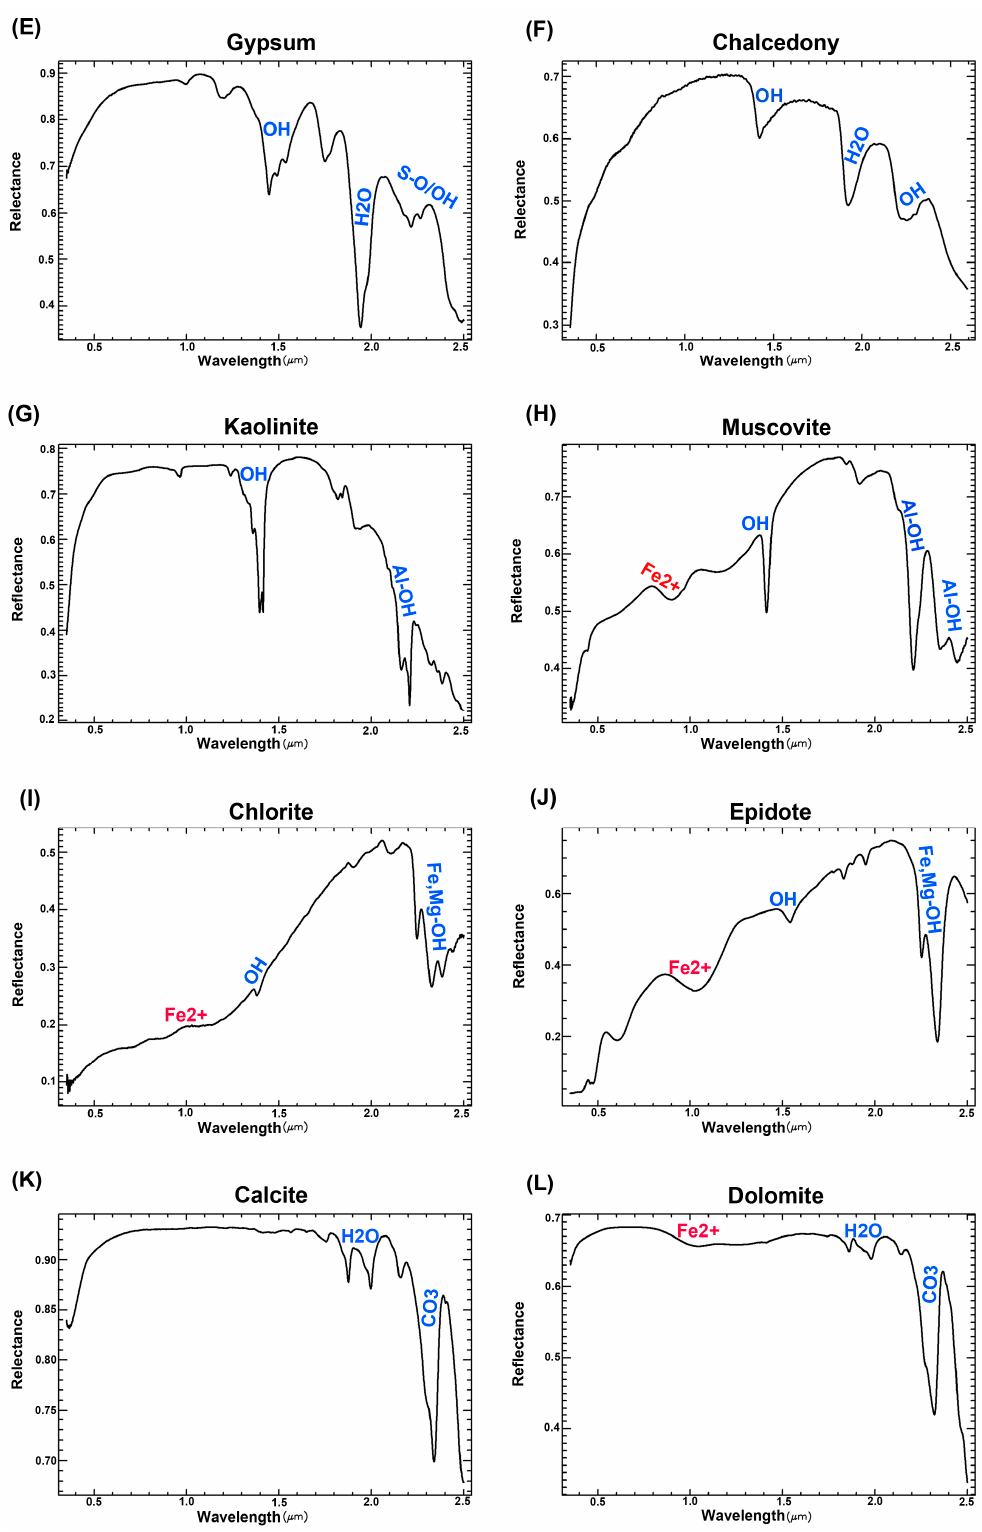
Figure 5. Laboratory reflectance spectra of the selected endmember minerals in the wavelength region from 0.4–2.5 μ m extracted from the USGS spectral library version 7.0 [67] for performing MTMF. ( A ) hematite; ( B ) goethite; ( C ) jarosite; ( D ) alunite; ( E ) gypsum; ( F ) chalcedony (hydrous-silica); ( G ) kaolinite; ( H ) muscovite; ( I ) chlorite; ( J ) epidote; ( K ) calcite; and ( L ) dolomite. Absorption features of the spectra annotate for the endmember minerals.